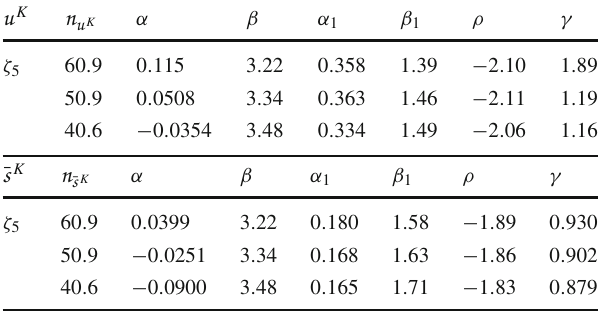
Fig. 10 u K ( x ; ζ 5 )/ u π ( x ; ζ 5 ) . Solid blue curve – result obtained after evolution of Eq.(29) [ π ] and Eq.(47) [ K ]. (Eq.(52) provides an inter- polation for this curve.) The light-blue band marks the domain between the results obtained using Eqs.(12), (45), Table 3–upper and Eqs.(12), (45),Table3–lower,with“lower”producingthesmallestvalueat x = 1. Data (orange) from Ref. [119] Table 5 Coefficients and powers that provide interpolations for the computed kaon valence-quark distribution functions, depicted in Fig.11, when used in Eq.(33): Rows 1–3 – u -quark; and Rows 4–6 – ¯ s -quark